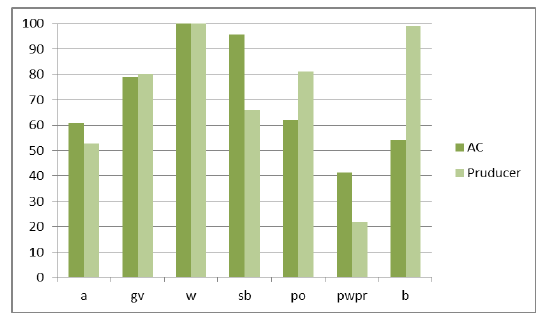
Figure 4 classification accuracy for both images